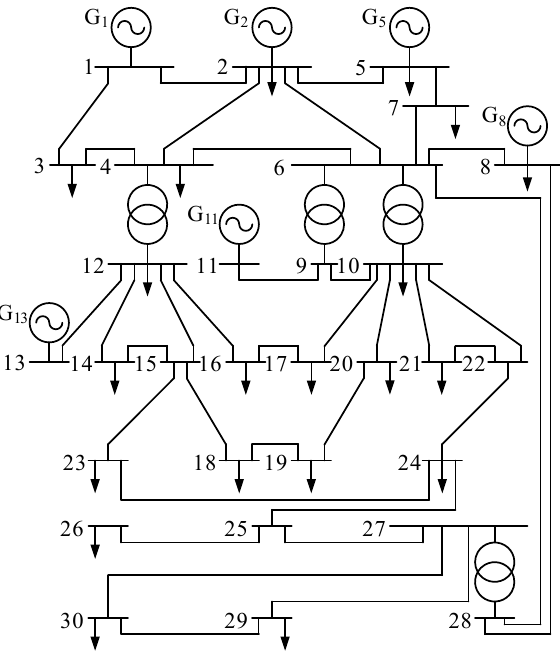
Figure 3. Single line diagram of the IEEE 30-bus test